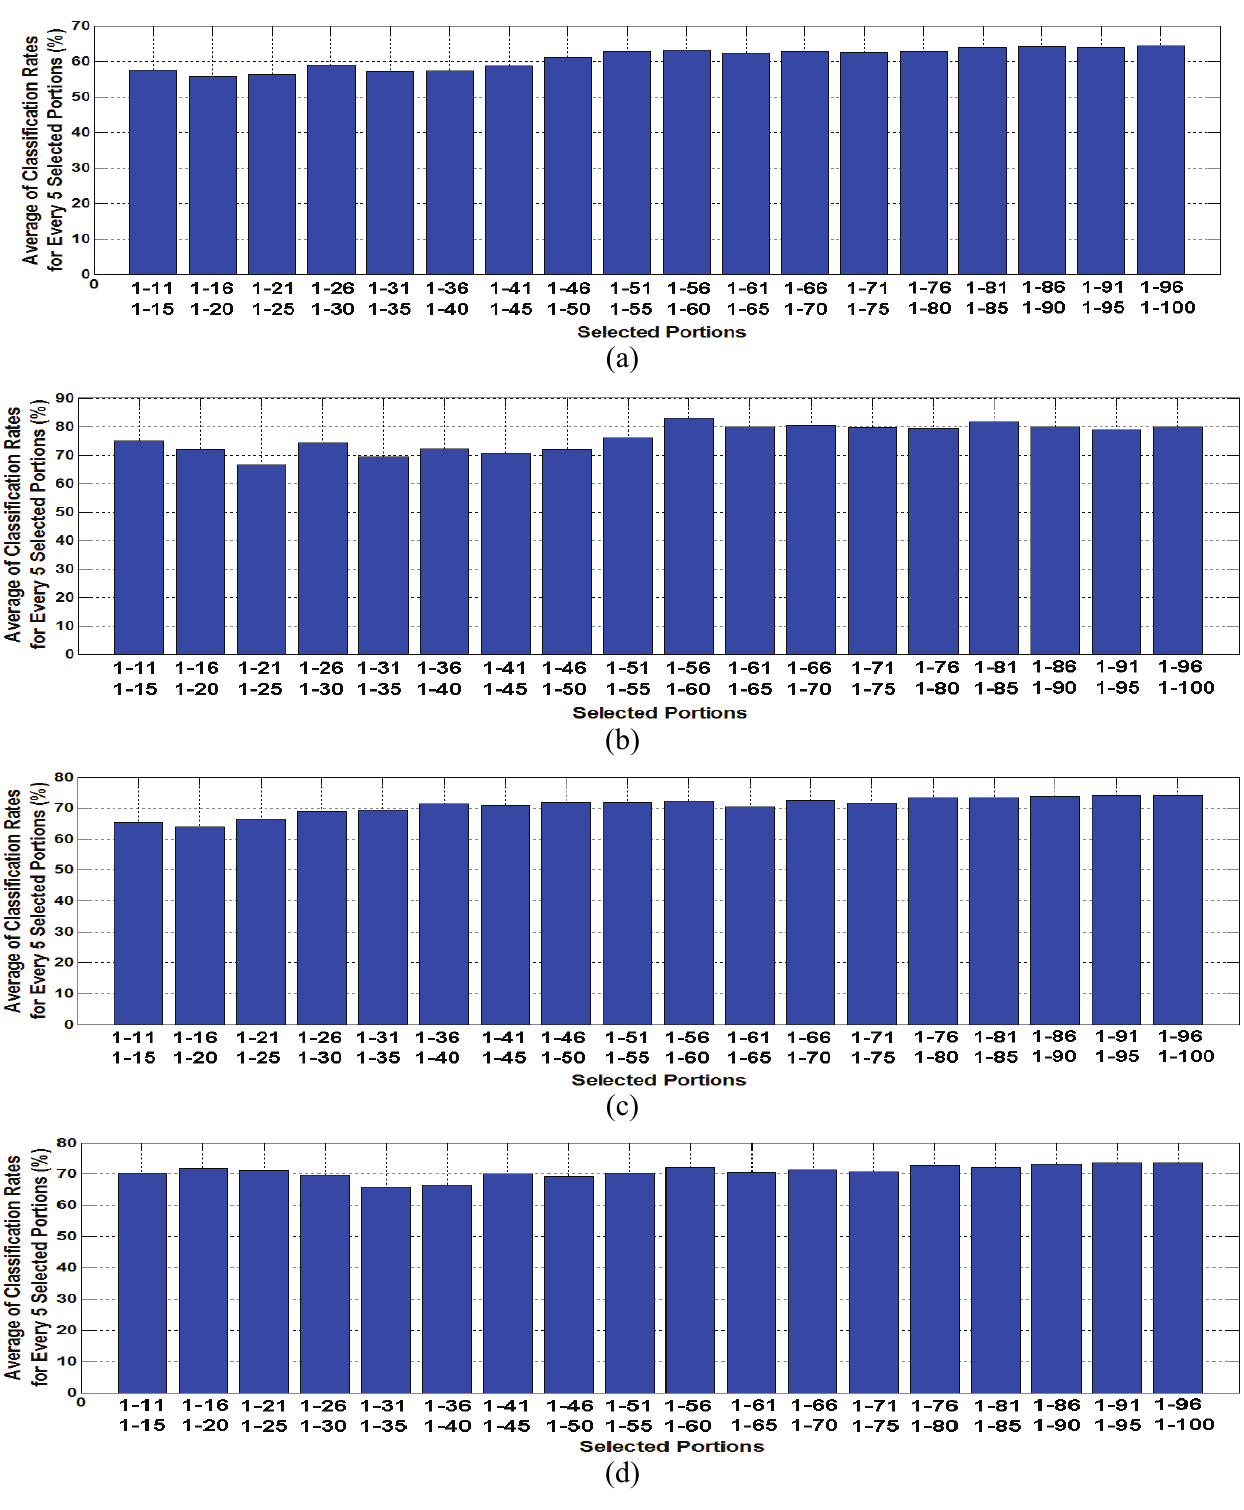
Figure 7. (a) Averages of evaluated classification rates for extracted features by PCA classified by the quadrate classifier. (b) The same for k-NN classifier. (c) The same for MLP classifier. (d) The same for SVM